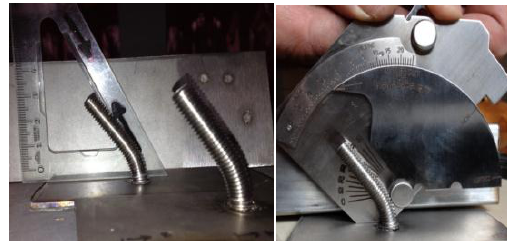
Figure 13. Bending angle determination of samples.